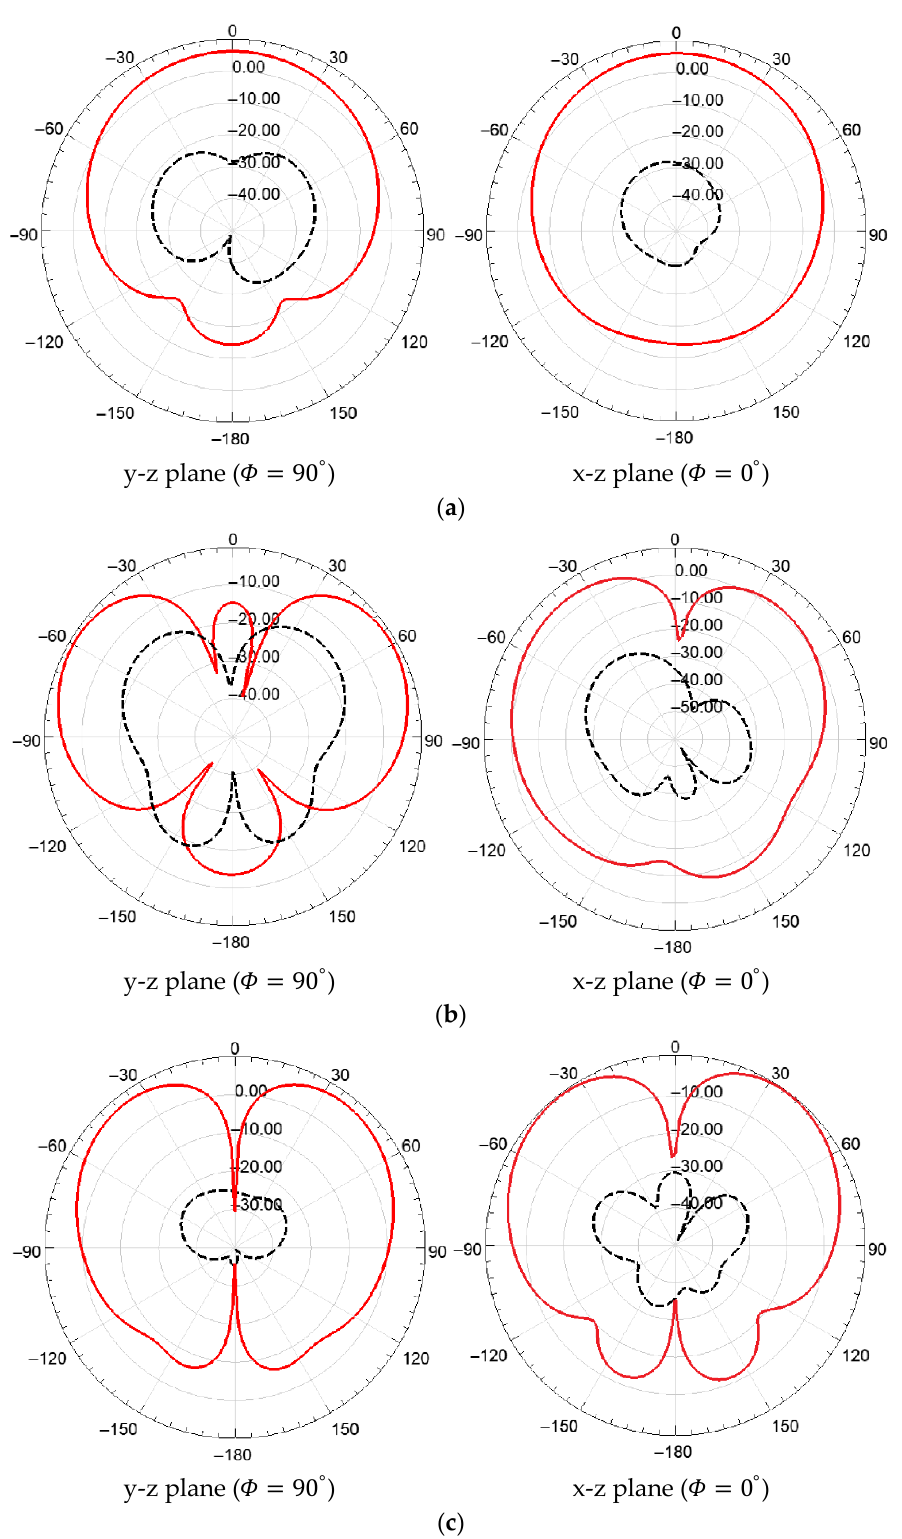
Figure 6. Co-pol. ( — ) and cross-pol. ( — ) radiation diagrams of MPATSAT in y–z ( Φ = 90 ◦ ) and x–z plane ( Φ = 0 ◦ ): ( a ) for 2.45 GHz; ( b ) for 4.73 GHz; ( c ) for 5.21